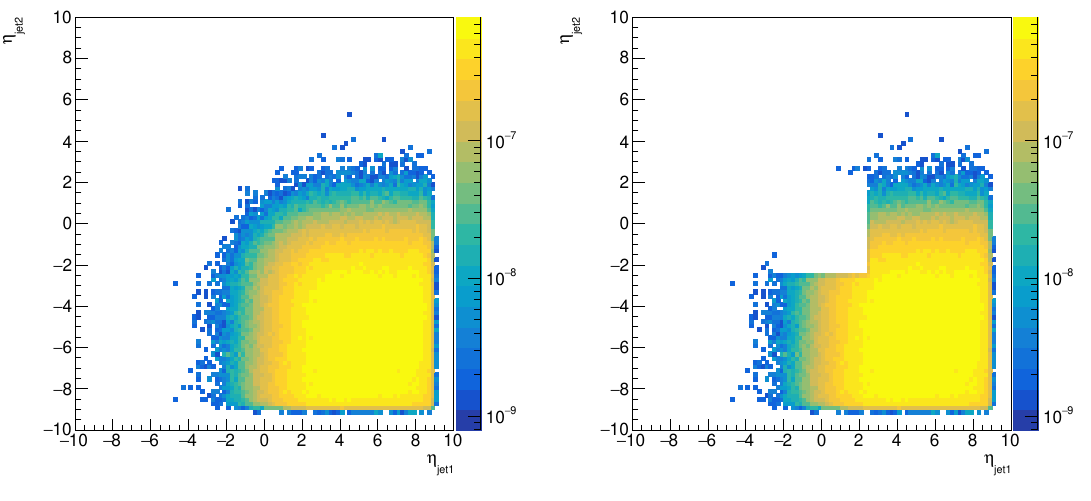
Figure 11 . The two-dimensional d 2 (cid:27) distribution as a function of (cid:17) jet1 ; (cid:17) jet2 in nb. The left d(cid:17) jet1 d(cid:17) jet2 panel shows distribution without cuts and the right panel with cuts on (cid:17) jet1 and (cid:17) jet2 .